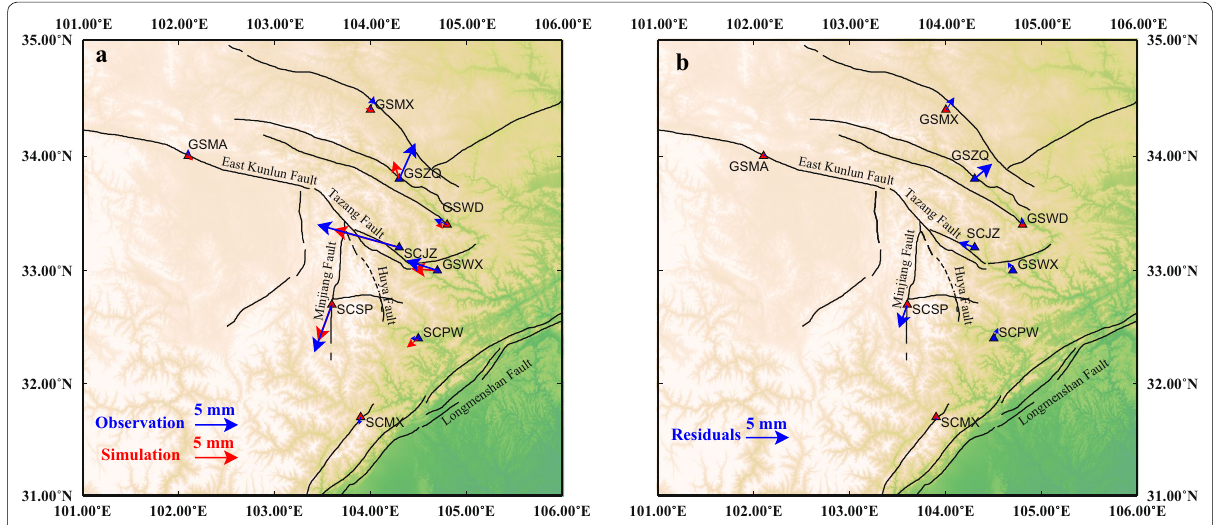
Fig. 5 a Observed and simulated coseismic deformation using GPS. b Horizontal residuals between observations and